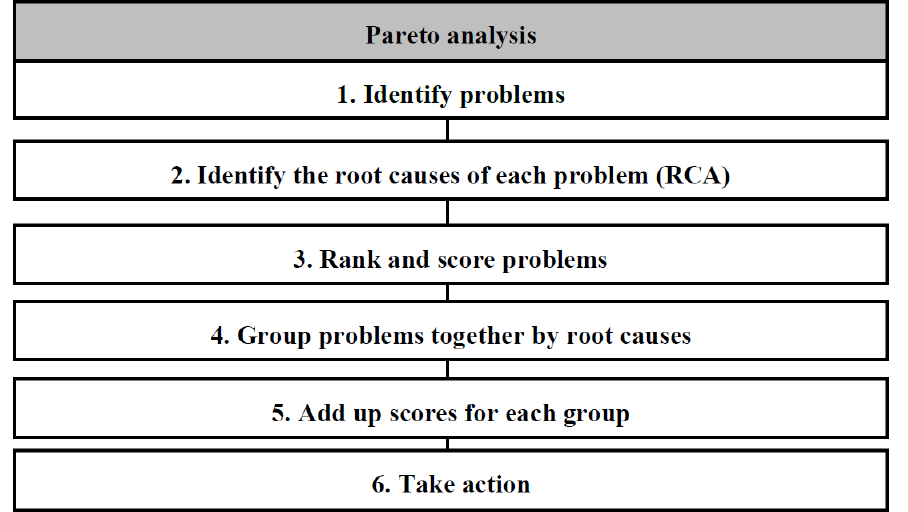
Figure 1. Basic steps of Pareto analysis, adopted from (Brooks 2014).